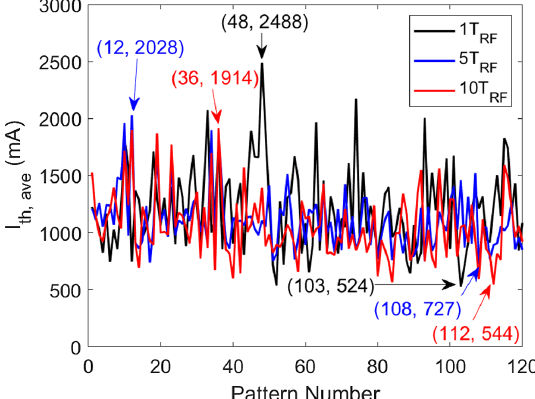
FIG. 7. Filling pattern dependence of the threshold current: (a) filling pattern No. 1 – 3; (b) filling pattern No. 59 – 61. The bunch spacing is 5 T rf .